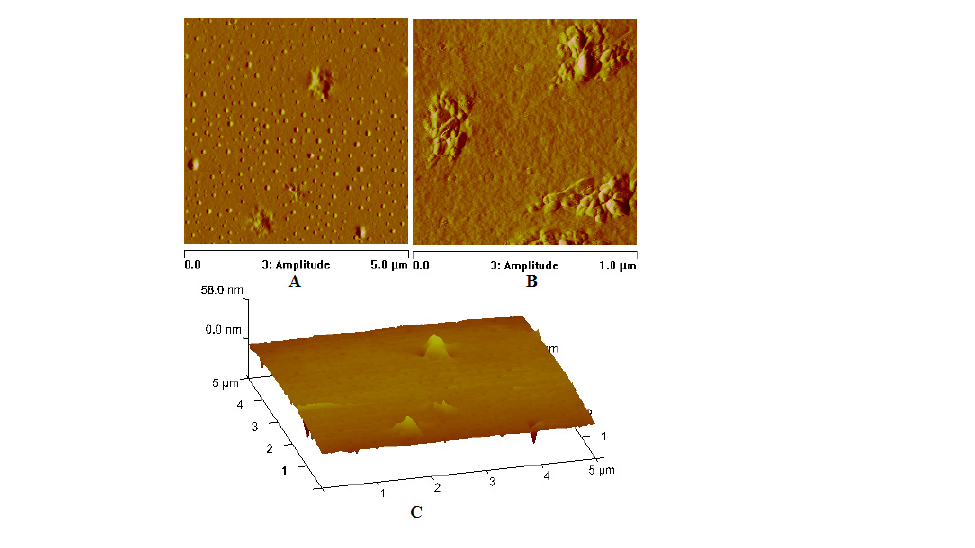
Figure 17. AFM images of [Cu 2 (EtNH 2 ) 2 (µ-O 2 CC 3 F 7 ) 4 ] ( 3 )/Si immersion time 30 s, amplitude Mag = 5 µm ( A ); Mag = 1 µm ( B ), height ( C ) before heating, dip coating, R a = 2.90 nm, R q = 3.98 nm. The [Cu 2 (EtNH 2 ) 2 (µ-O 2 CC 2 F 5 ) 4 ] ( 2 ) complex forming materials obtained by deposi-